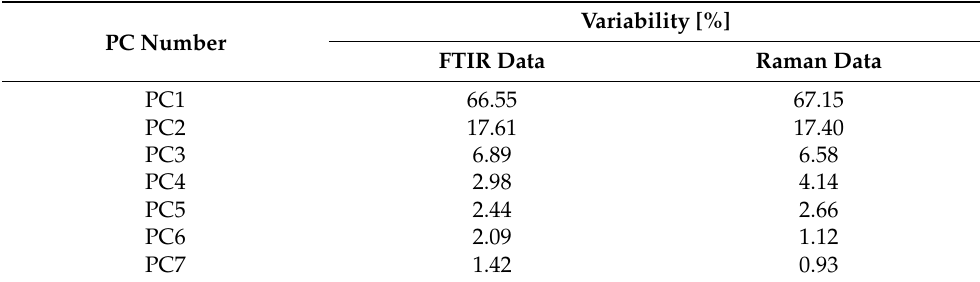
Table 8. Variability explained by the principal components (PCs) obtained by decomposition of the spectral data (red grape pulp extracts) using principal component analysis (PCA).